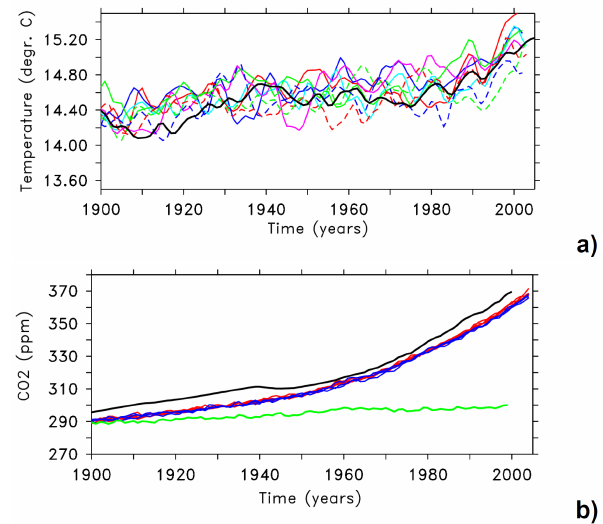
Fig. 2. NH temperature and global CO 2 concentration in the 20th century. ( a) 20th century Northern Hemisphere (land and ocean) 2m air temperatures (5-year running means) simulated in ensemble E1 (solid coloured lines) and E2 (dashed coloured lines) in comparison with the HadCRUT3v dataset (black line, ob- tained from the Climatic Research Unit, http://www.cru.uea.ac.uk/ cru/data/temperature), (b) 20th century global CO 2 concentration (yearly data) simulated in ensemble E1 (red) and E2 (blue) in com- parison with a combination of ice core data and atmospheric mea- surements (black) provided by the Paleo Model Intercomparison Project at http://pmip3.lsce.ipsl.fr. The green line is the respective curve for the land-cover-change-only